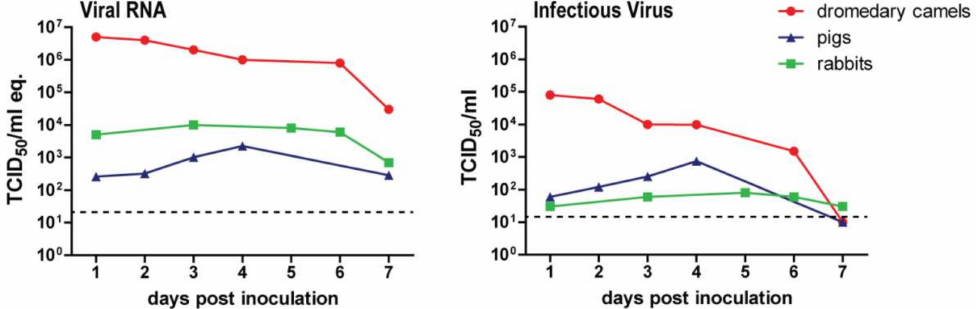
Figure 2. Schematic overview of viral RNA and infectious virus shedding of MERS-CoV-inoculated dromedary camels, pigs, and rabbits. Each data point represents the average data from previous experiments [17,33,84]. Viral RNA is measured in TCID 50 /mL genome equivalents, while infectious virus is expressed in TCID 50